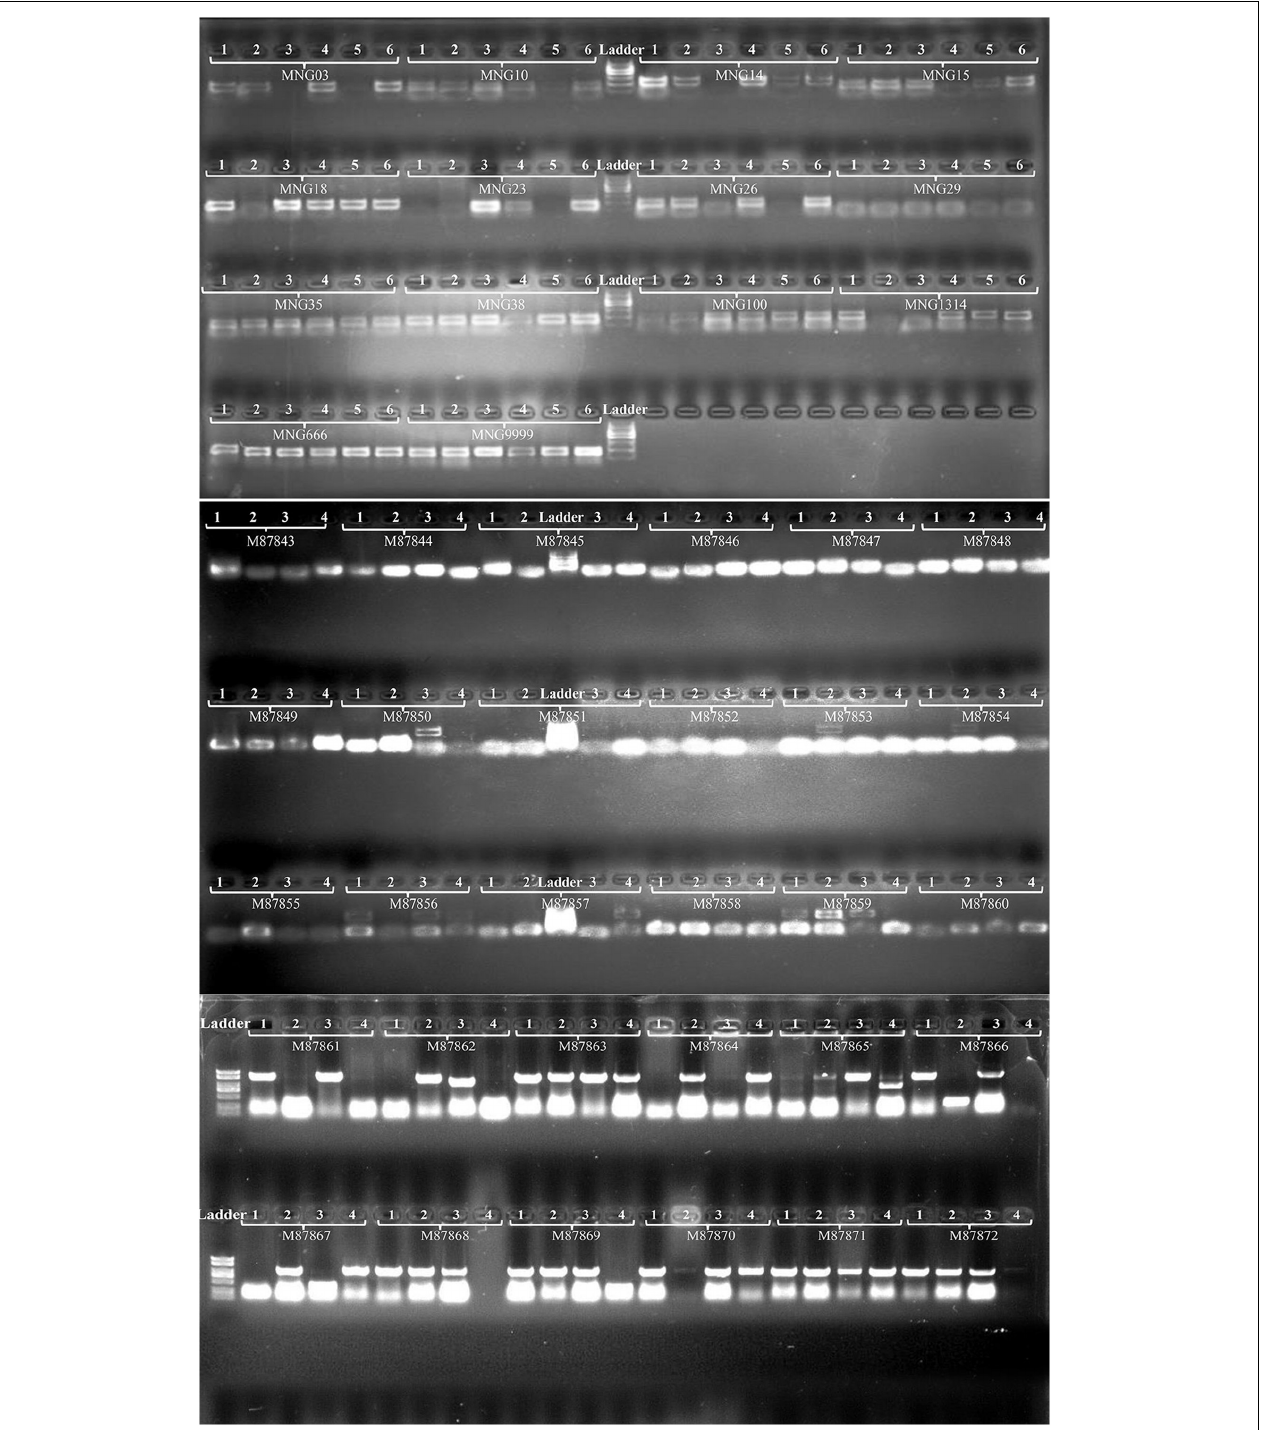
FIGURE 7 | Genetic diversity of 44 genomic SSR loci in four or six Munake cultivar accessions.